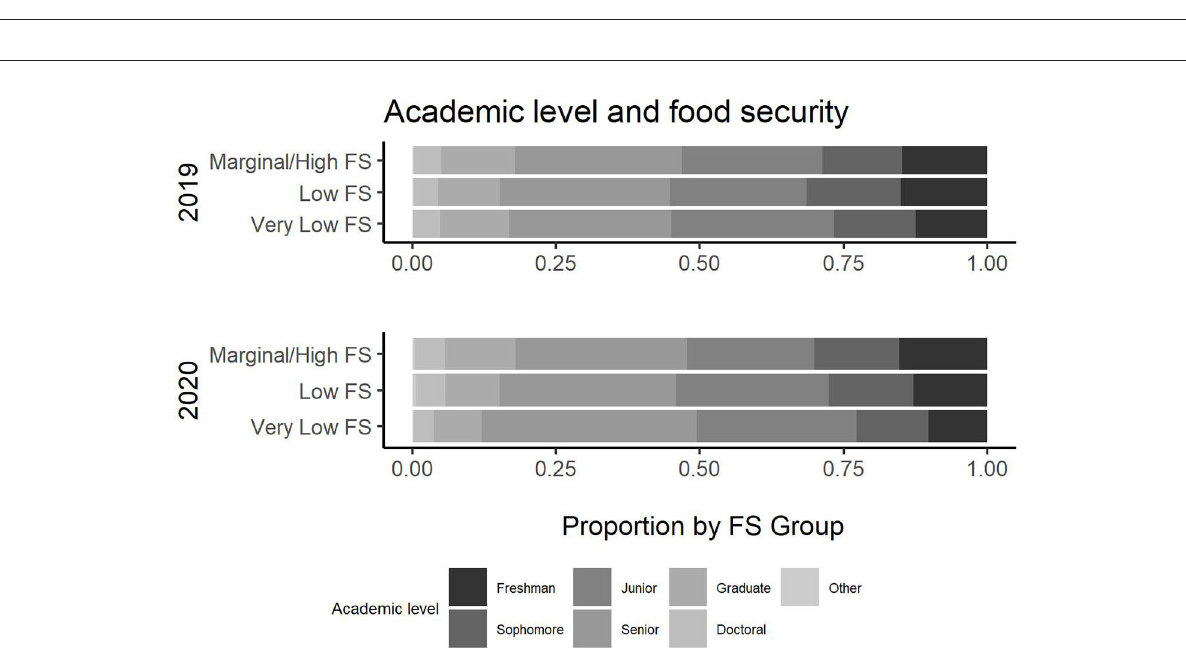
FIGURE5 Academic level and food